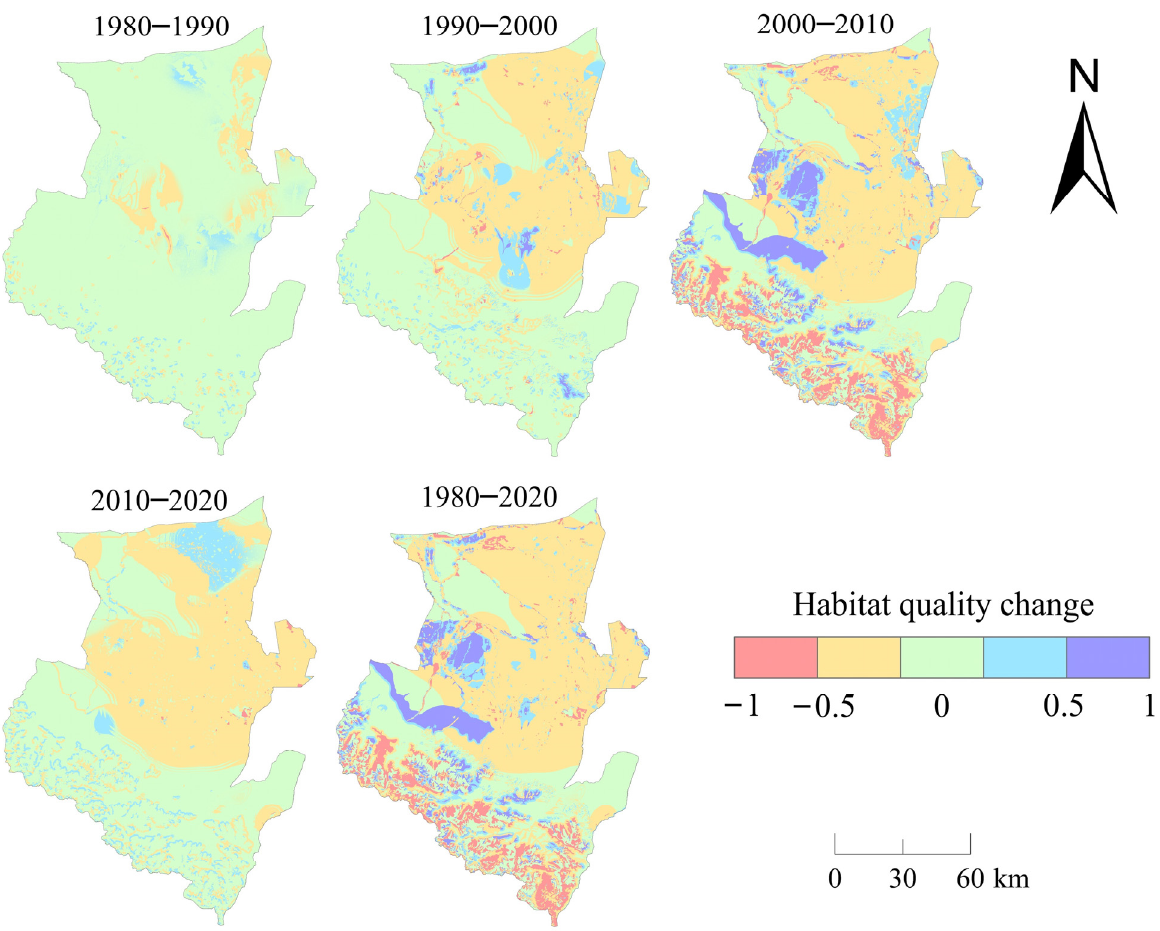
Figure 8. The temporal and spatial changes of HQ of Wusu. From 2000 to 2010, the changes in the spatial distribution of HQ were significantly intensified, and the areas with no changes were rapidly reduced. The weak changes were the most widely distributed and were still distributed in the central and northeastern regions. The distribution area of positive and negative strong changes has significantly increased. The positive strong changes were mainly distributed in the west of Wusu, and the negative strong changes were mainly distributed in the southern mountainous areas and other sporadic areas. The HQ in 2010 decreased by 6.19% compared with that in 2000. The changes in HQ during this period were the most drastic among the four periods from 1980 to 2020, both numerically and spatially. The area with no change in HQ from 2010 to 2020 was the largest, and the negative weak changes were still focused on the central and northeastern regions. The distribution area of the positive weak change was second to that of the negative weak change, and it was mainly distributed in the northeast of Wusu in a mass form, and the positive and negative weak changes also had sporadic distribution in the southern mountainous area. Negative strong changes were distributed in the eastern part of Wusu City, while positive strong changes showed almost nothing in space. From 1980 to 2020, the most dramatic changes in land use and HQ occurred from 2000 to 2010, indicating that land use change has a certain impact on HQ